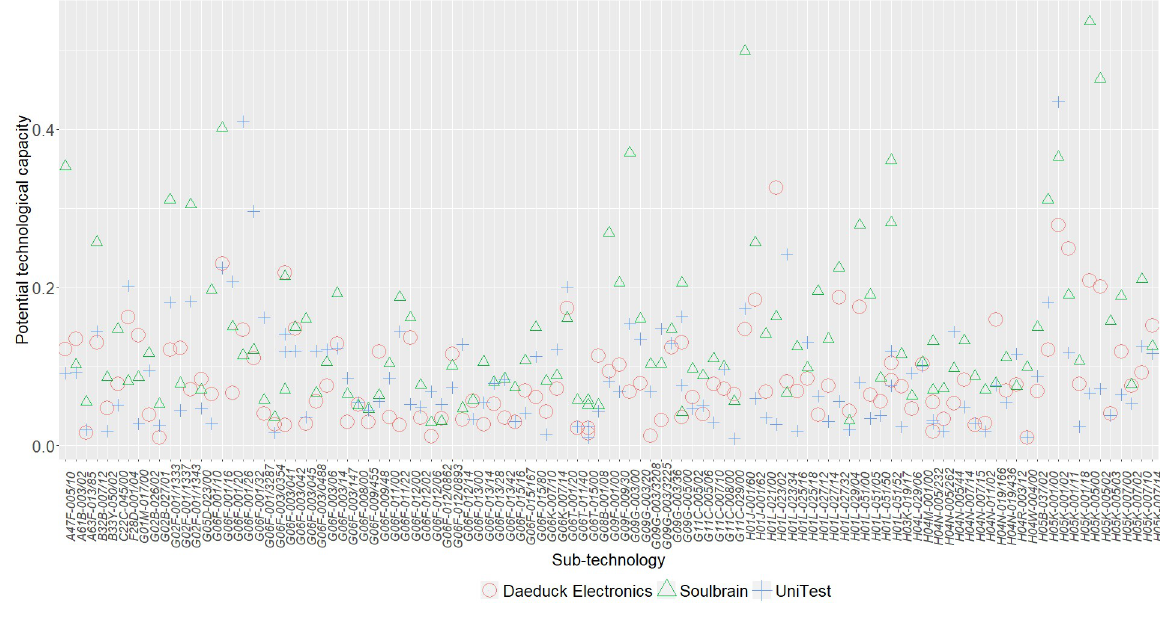
Fig 3. Potential technological capability of each subcontractor for